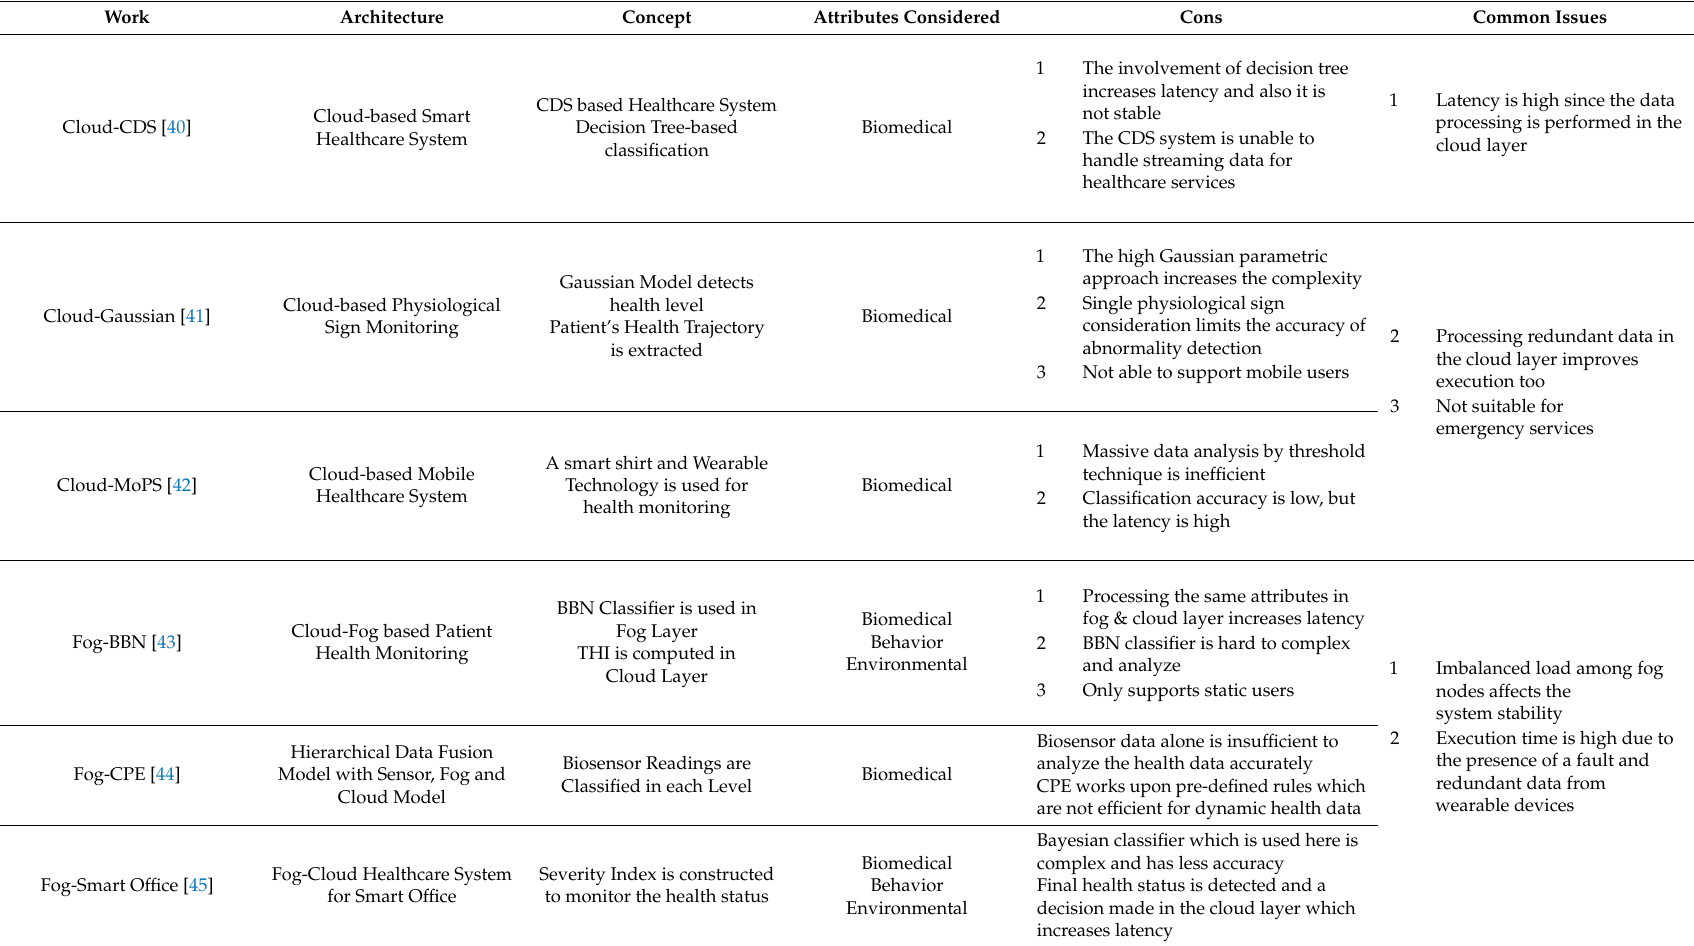
Table 6. Comparison of Prior